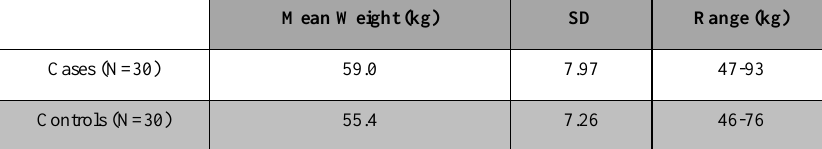
Table 4. The weight distribution of study subjects among case and control groups.